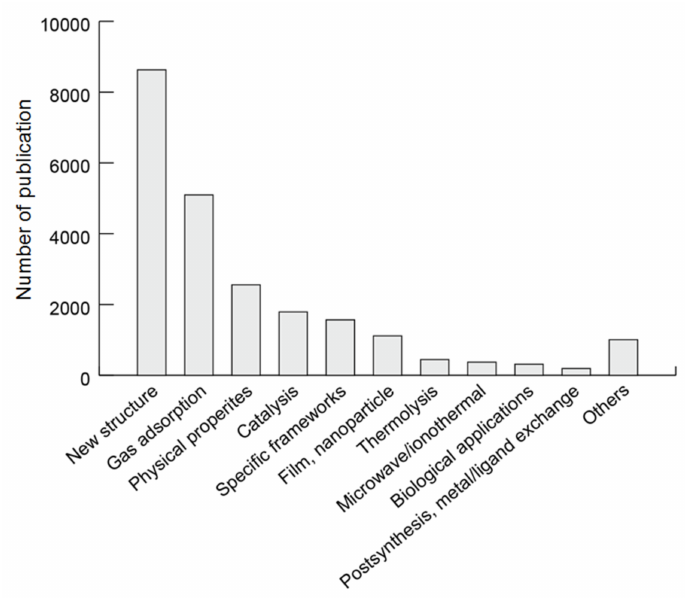
Figure 5. Research areas for MOFs from citation network